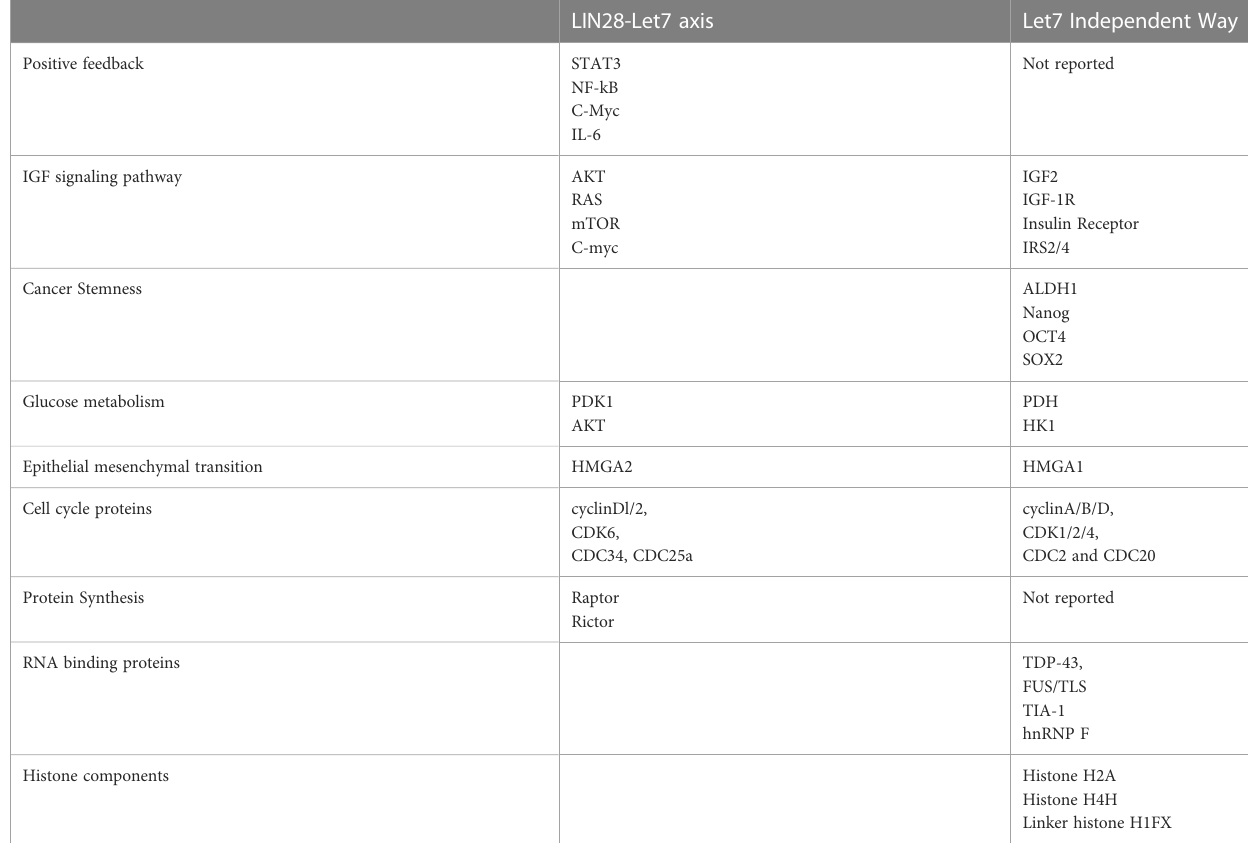
TABLE 1 Lin28 regulates Let7 related and Let7 independent targets in cancer.